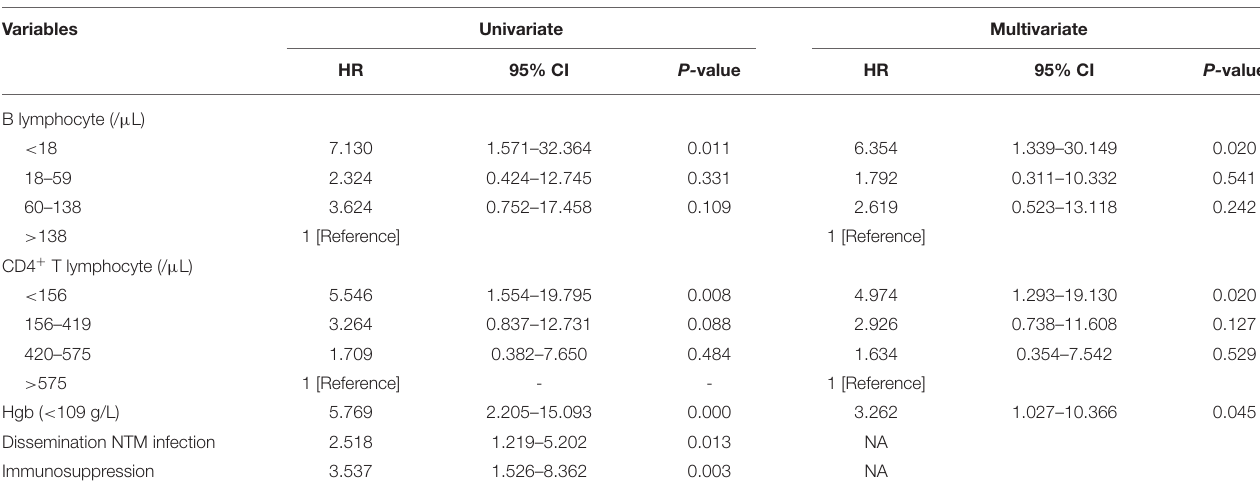
TABLE 3 | Factors associated with all-cause mortality in NTM